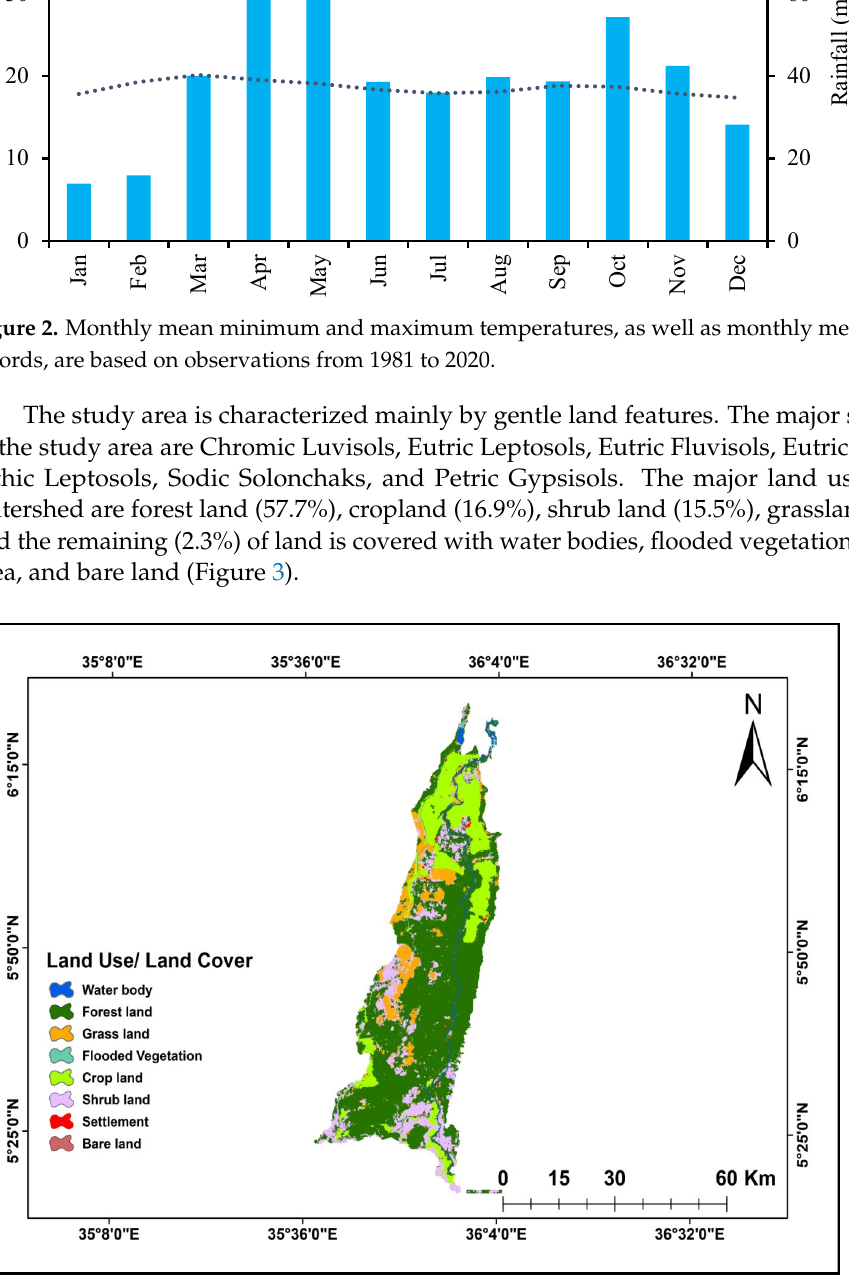
Figure 3. Land use/land cover types of the study area .